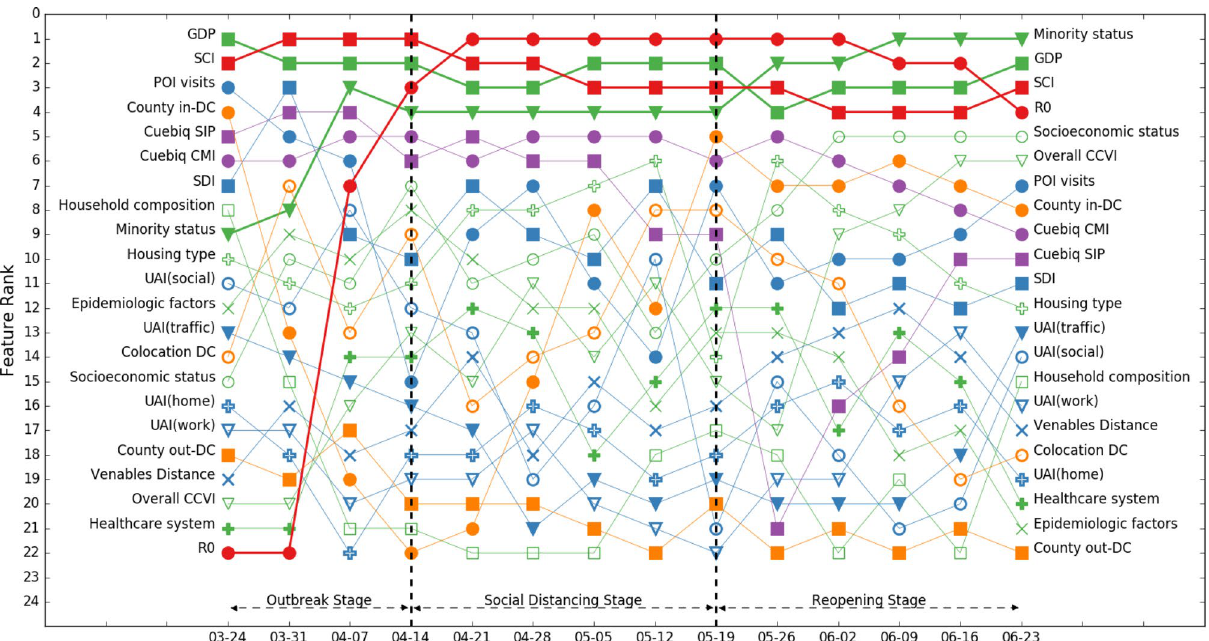
Figure 4. Rank of feature importance of model 2 throughout three stages of COVID-19. Social demographic features and social network structure features show high importance throughout three stages of